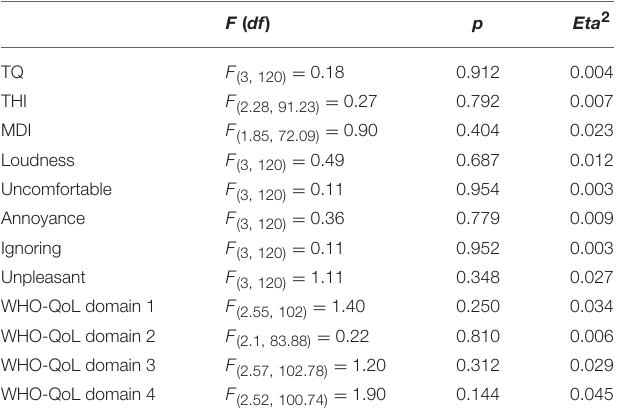
TABLE 2 | Results from repeated measures analyses of variance.